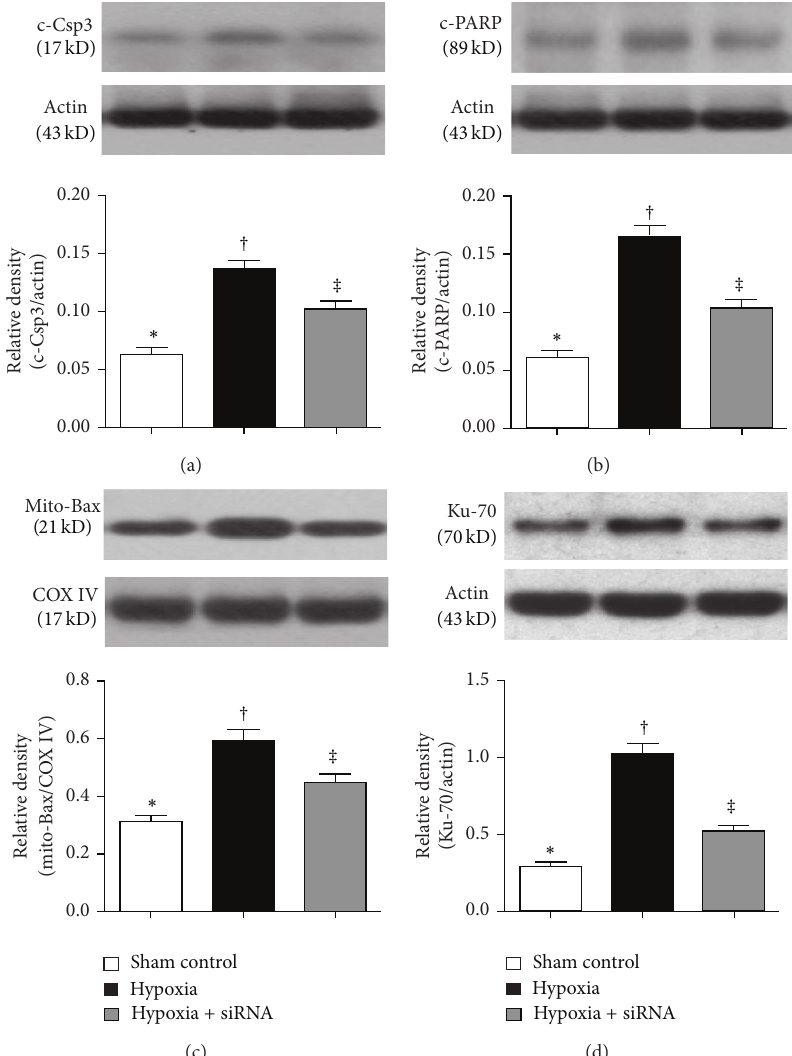
Figure 9: Protein expressions of apoptotic and DNA repair biomarkers in lung parenchyma by day 28 after hypoxia-induced pulmonary arterial hypertension (PAH) ( 𝑛 = 10 ). (a) Protein expressions of cleaved caspase-3 (c-Csp3), ∗ versus other groups with different symbols ( ∗ , † , ‡ ), 𝑃 < 0.01 . (b) Protein expression of cleaved poly(ADP-ribose) polymerase (c-PARP), ∗ versus other groups with different symbols ( ∗ , † , ‡ ), 𝑃 < 0.001 . (c) Protein expression of mitochondrial Bax (mito-Bax), ∗ versus other groups with different symbols ( ∗ , † , ‡ ), 𝑃 < 0.01 . (d) Protein expression of Ku-70, ∗ versus other groups with different symbols ( ∗ , † , ‡ ), 𝑃 < 0.001 . Statistical analysis in ((a) to (d)) using one-way ANOVA, followed by Bonferroni multiple comparison post hoc test. Symbols ( ∗ , † , ‡ ) indicate significance (at 0.05